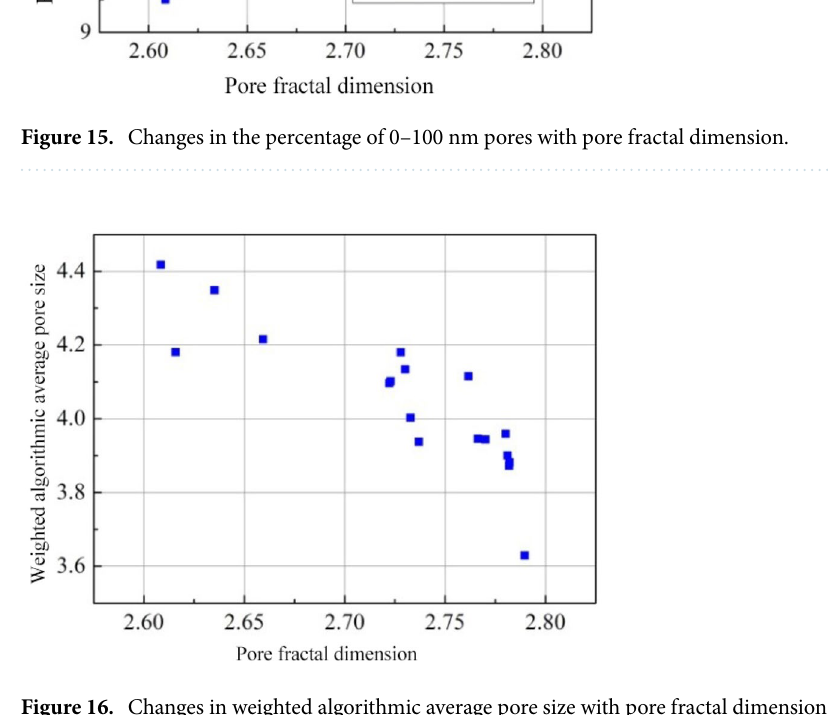
Figure 16. Changes in weighted algorithmic average pore size with pore fractal